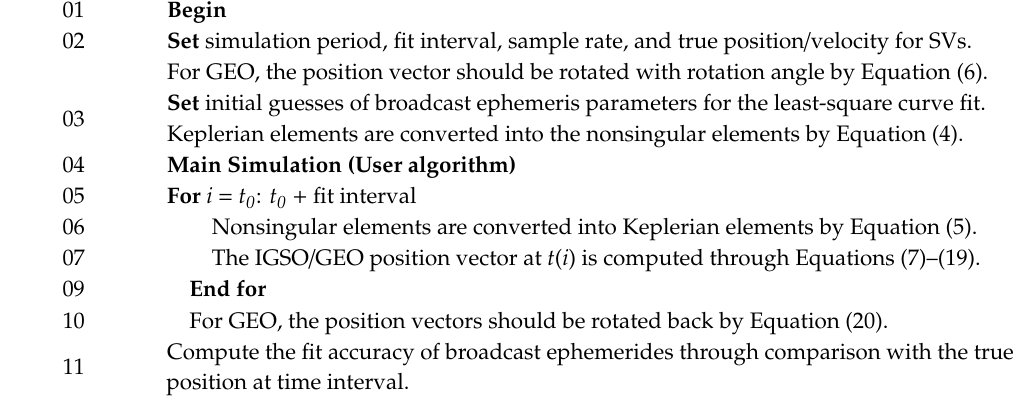
Algorithm 1: Procedures for Least-Square Curve Fit of Broadcast Ephemeris Parameters